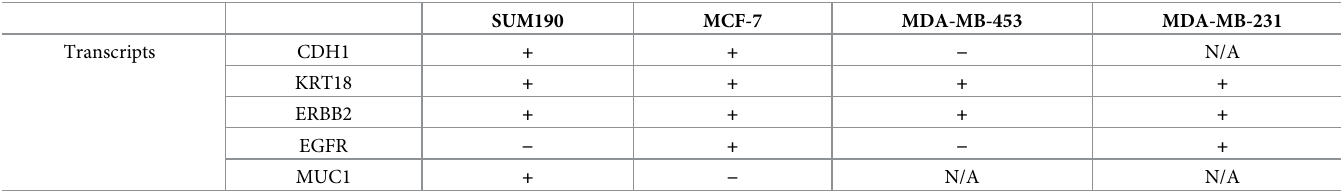
Table 2. QuantiGene branched DNA